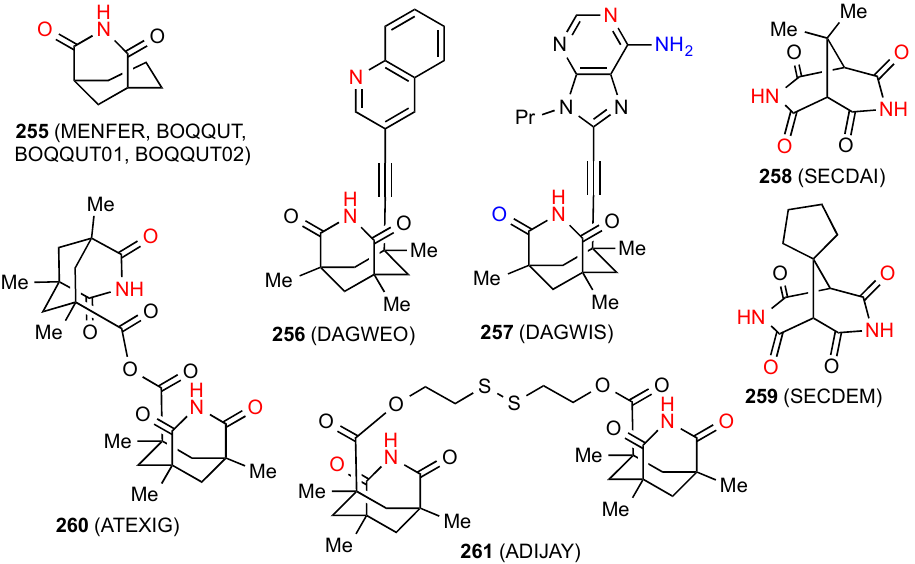
Figure 73. Bridged six-membered ring imides with pattern B , C and H structures.